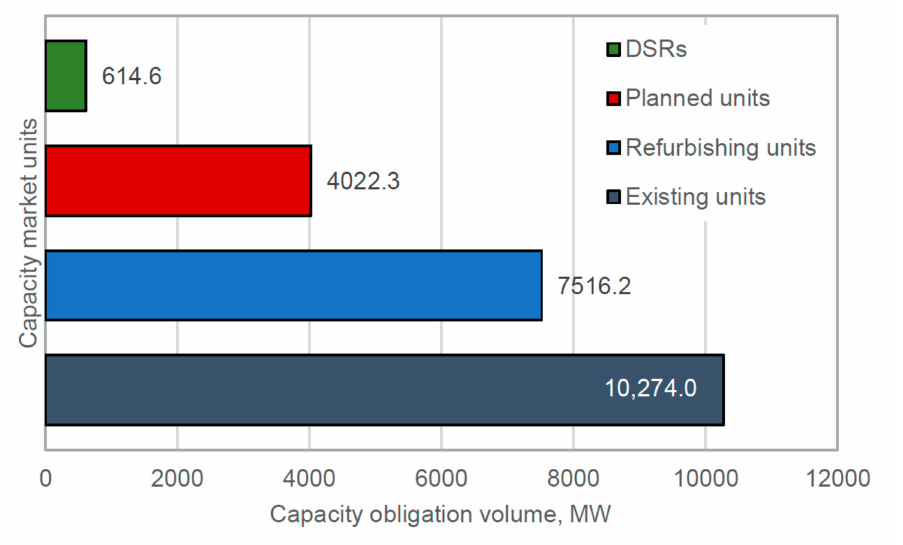
Figure 3. Capacity obligation volume contracted in main capacity auction for 2021 delivery year– break down by official (declared) assignments to capacity market units. Source: Own analysis based on